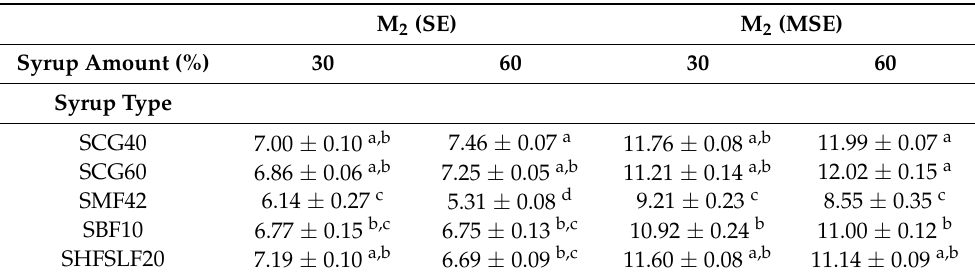
Small letters indicate the significant differences ( p < 0.05) between the samples in each column. Errors are represented as standard